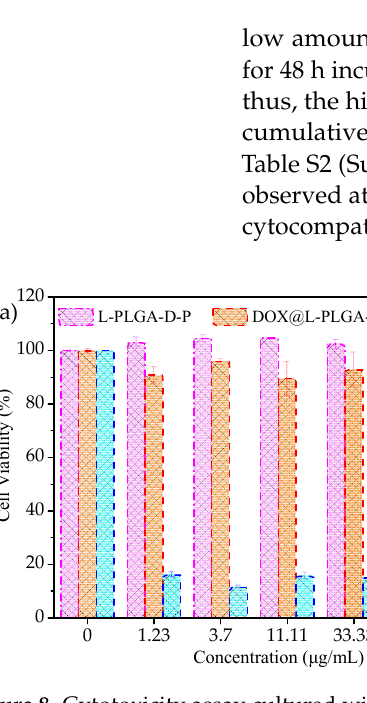
Figure 8. Cytotoxicity assay cultured with ( a ) L-PLGA-D-P, DOX@L-PLGA-D-P, free DOX and ( b ) S-PLGA-D-P, DOX@S- PLGA-D-P, free DOX for 48 h incubation at different concentrations of samples against NIH-3T3 cells.